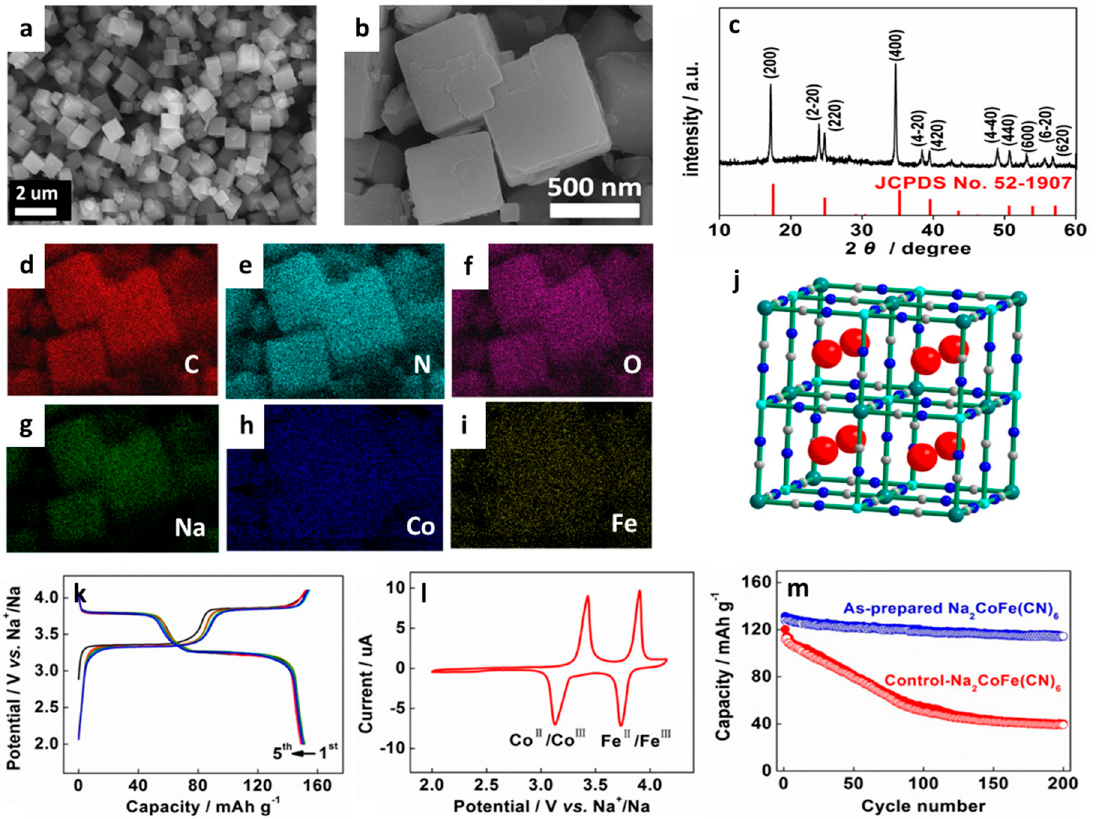
Figure 13. Structural characterization and electrochemical performance analysis of Prussian blue (PB) as a cathode in SIBs. ( a ) and ( b ) SEM images at low and high magnification of the sodium rich PB crystals depicting an uniform cubical morphology. ( c ) XRD pattern of the synthesized PB sample demonstrating high degree of crystallinity. ( d – i ) Elemental mapping of the PB sample demonstrating the different constituent elements with uniform distribution. ( j ) Schematic representation of the PB crystal showing the FCC (face centered cubic) lattice structure, with the Na atoms occupying the interstitial red sports. ( k ) Galvanostatic charging-discharging curves of the half-cell with PB cathode. ( l ) CV of the PB cathode system vs. Na/Na + showing the characteristic redox peaks ( m ) Capacity retention of the PB cathode compared with a control, which is a more defect-filled PB structure. Copyright 2016, American Chemical Society.